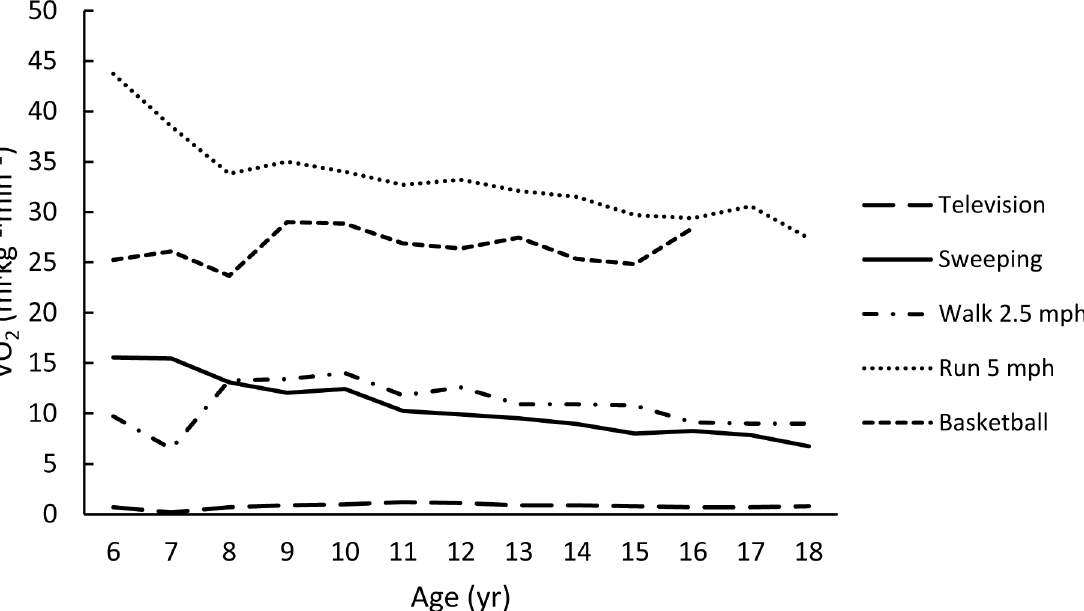
Fig 3. The relationships between age and VO 2NET (Activity VO 2 – RMR; ml . kg -1. min -1 ) for six activities representing various intensities of physical activities.